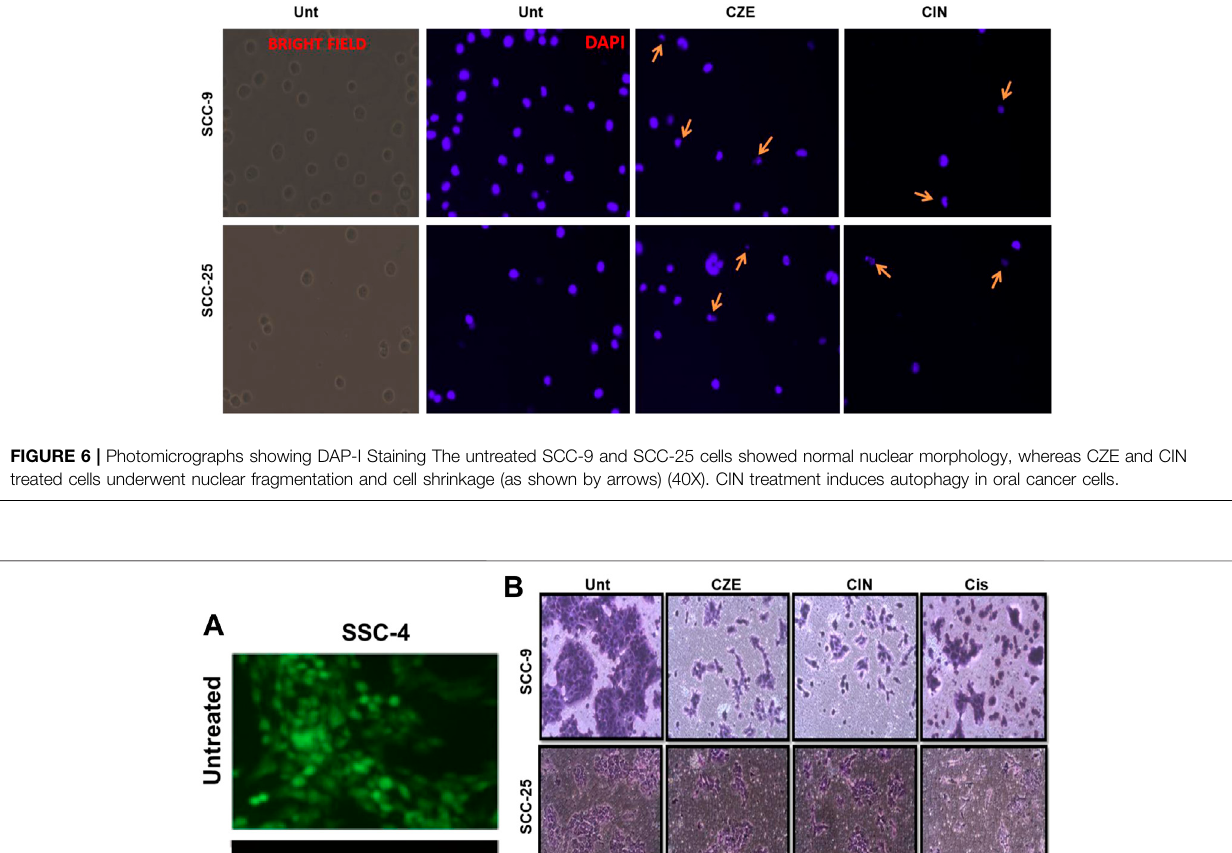
Figure 2 , microscopic observation revealed signi fi cant morphological changes in OSCC cells after the drug treatment, such as detachment and cell shrinkage. Also, the healthy PBMCs showed minimal cytotoxicity ( < 5%) after CZE and CIN treatments (data not shown).